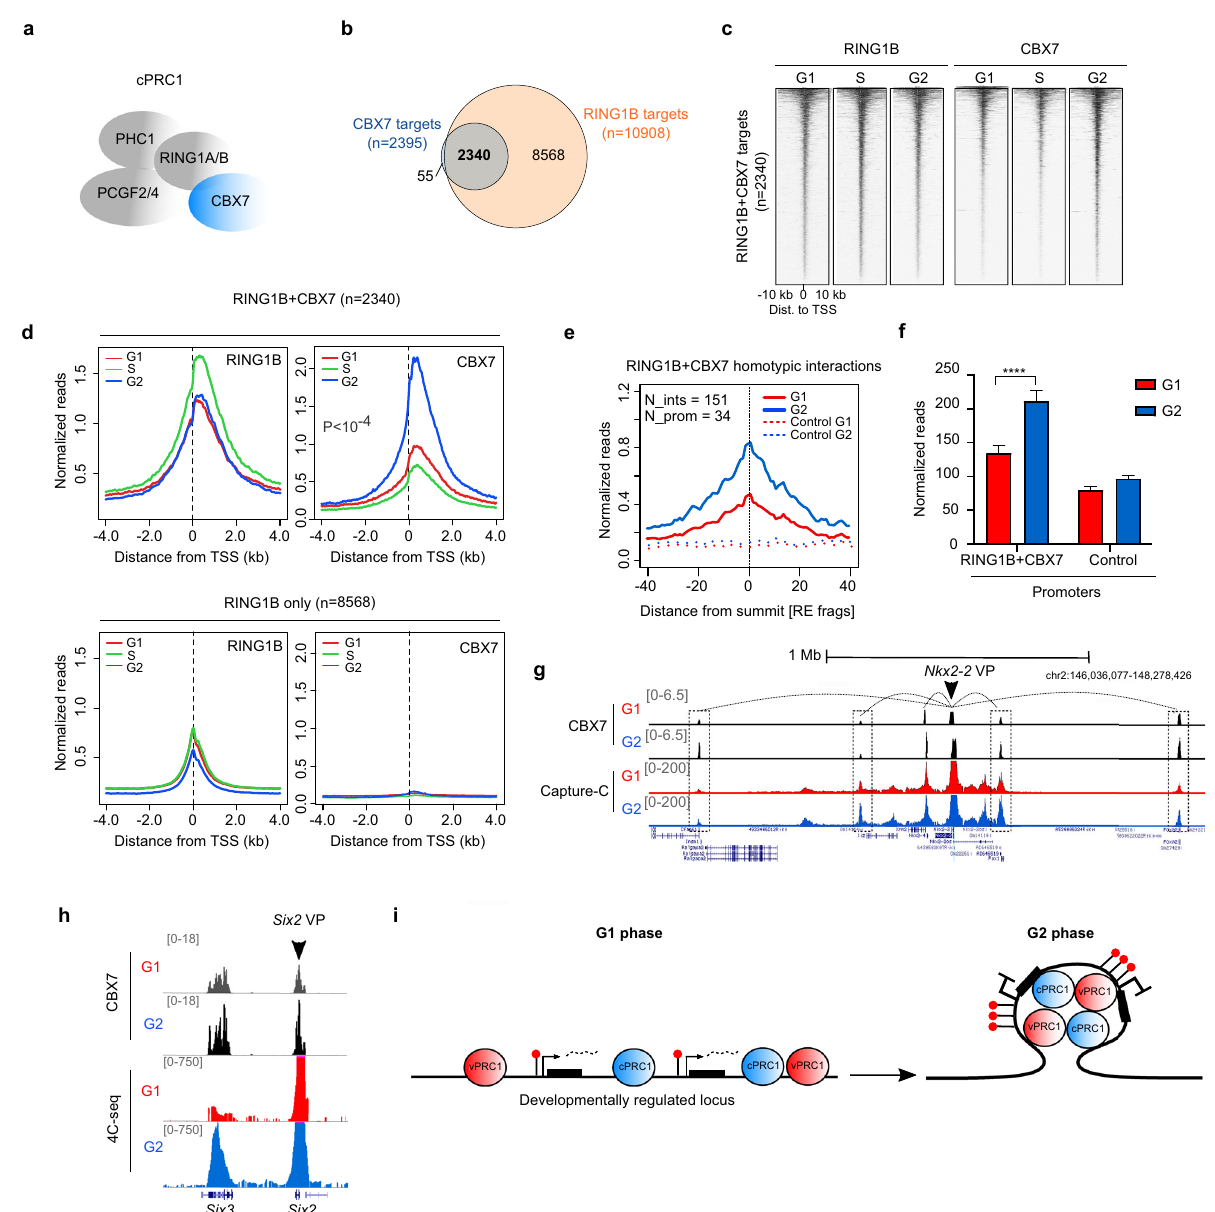
Fig. 3 | Accumulation of CBX7 at target genes is coupled to strengthen promoter-promoter contacts during G2 phase. a Scheme highlighting CBX7 (blue)incPRC1complexesinmESCs. b Venndiagramshowingtheoverlapbetween RING1B (orange) and CBX7 (blue) target promoters. c Heatmaps of normalized RING1B and CBX7 ChIP-seq reads around the TSS (±10kb) of promoters bound by RING1BandCBX7(asidenti fi edin b )atdifferentcellcyclephases.Genesareranked accordingtothesignalofRING1BinG2phase. d Averagebindingpro fi leofRING1B andCBX7aroundtheTSSofRING1B-boundpromotersthataretargeted(toppanel) or not (bottom panel) by CBX7 in G1 (red), S (green) and G2 (blue) phases. P indicatesone-wayANOVAtest p -value. e Averagenormalizedreadsof3Dchromatin interactions ( n =151) measured by capture-C of RING1B+CBX7-bound regions involving at least one promoter (n° of promoters=34) in G1 (red) and G2 (blue) phases.The X -axisrepresentsthedistancefromthesummitoftheinteractionpeak measured as a function of DpnII restriction fragments. Dashed lines show enrich- ment at distance-matched control sites from each promoter and interaction in the opposite direction. f Capture-C average normalized reads of interactions involving